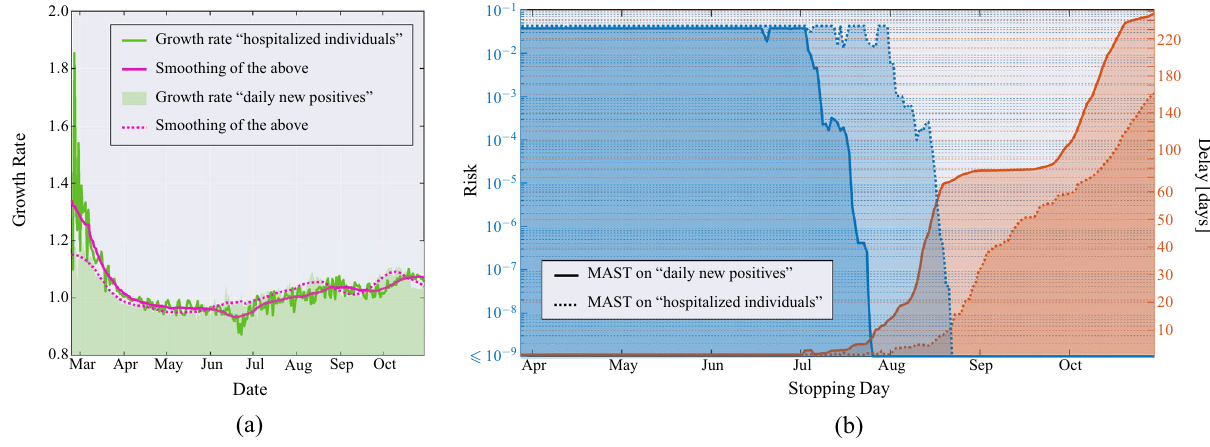
Figure 6. ( a ) Growth rate of the hospitalized individuals (green solid line)—and its time-varying mean obtained through a moving average that uses a window of 21 days (magenta solid line)—compared to the growth rate of the daily new positives individuals (green area)—and its time-varying mean (magenta dotted line)—in Italy since February 21, 2020. ( b ) Application of the MAST procedure on the growth rate sequence of the daily new positive individuals (solid lines, already shown in Fig. 4) and on the growth rate sequence of the hospitalized individuals (dotted lines). On the left-side vertical axis we select a desired risk, e.g., R = 10 − 4 . Then, the blue curves indicate the stopping day (about July 18 if the growth rate sequence of the daily new positive individuals is used, and August 10 if the growth rate sequence of the hospitalized individuals is used) corresponding to the selected value of risk. Finally, the red curves referred to the right-side vertical axis show the mean delay (cid:31) corresponding to the selected risk R (about 3 days if the growth rate sequence of the daily new positive individuals is used, and below 5 days if the growth rate sequence of the hospitalized individuals is used). For clarity, note that the right-side scale for the delay is split into two linear ranges, for a better rendering of the small- (cid:31)